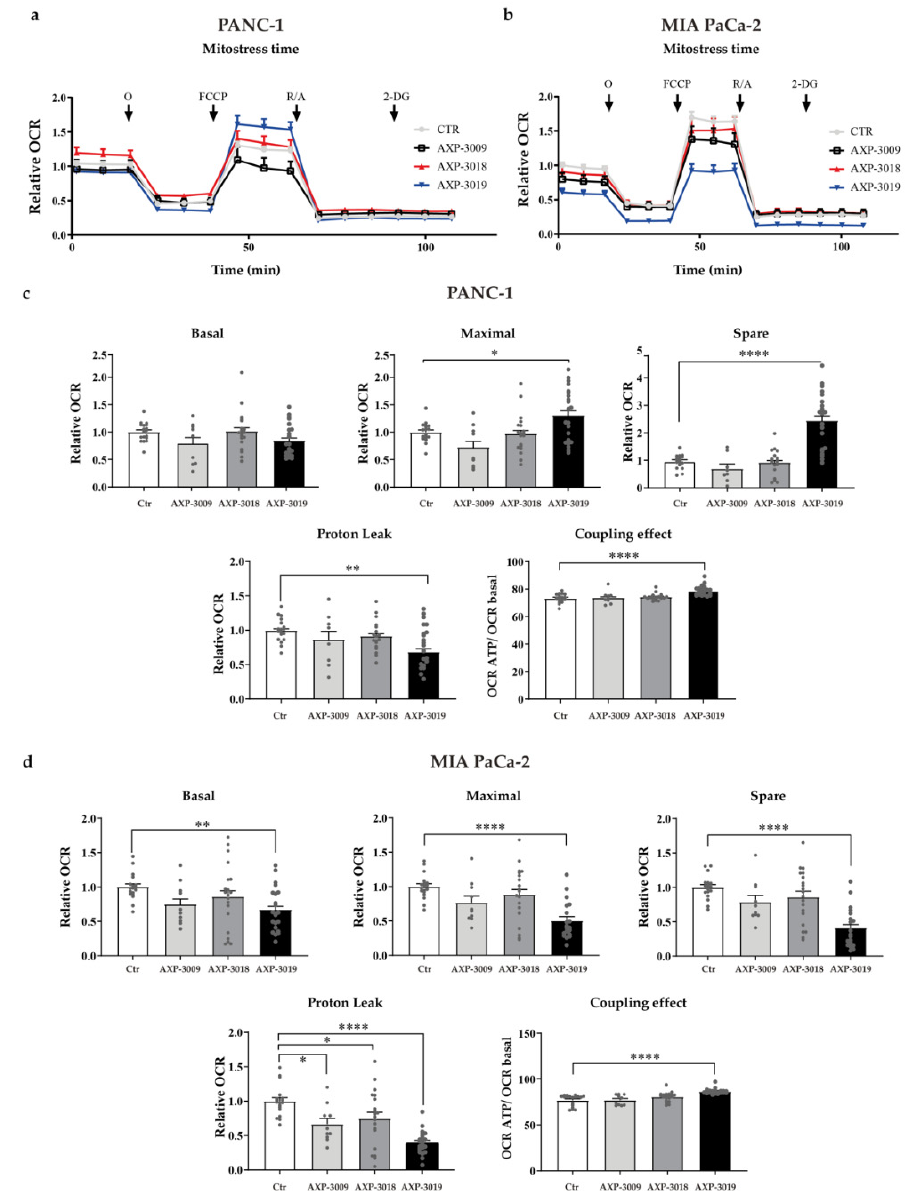
Figure 5. Mitochondrial metabolism in PDAC cell lines. Representative graphs of OCR profiles of PANC-1 ( a ) and MIA PaCa-2 ( b ) treated with 10 μ M of 3-bromo-isoxazoline derivatives for 48 h; O = oligomycin; FCCP = Carbonyl cyanide 4-(trifluoromethoxy)phenylhydrazone; R/A = Rotenone/Antimycin A; 2-DG = 2-Deoxy-D-glucose. The parameters of mitochondrial respiration ( c , d ) were normalized on the total DNA content per well, calculated as detailed in Material and Methods and expressed as fold-change compared to untreated controls. Statistical analysis was performed with one-way ANOVA and Dunnett’s multiple comparisons test * p < 0.05, ** p < 0.005, **** p < 0.0001.